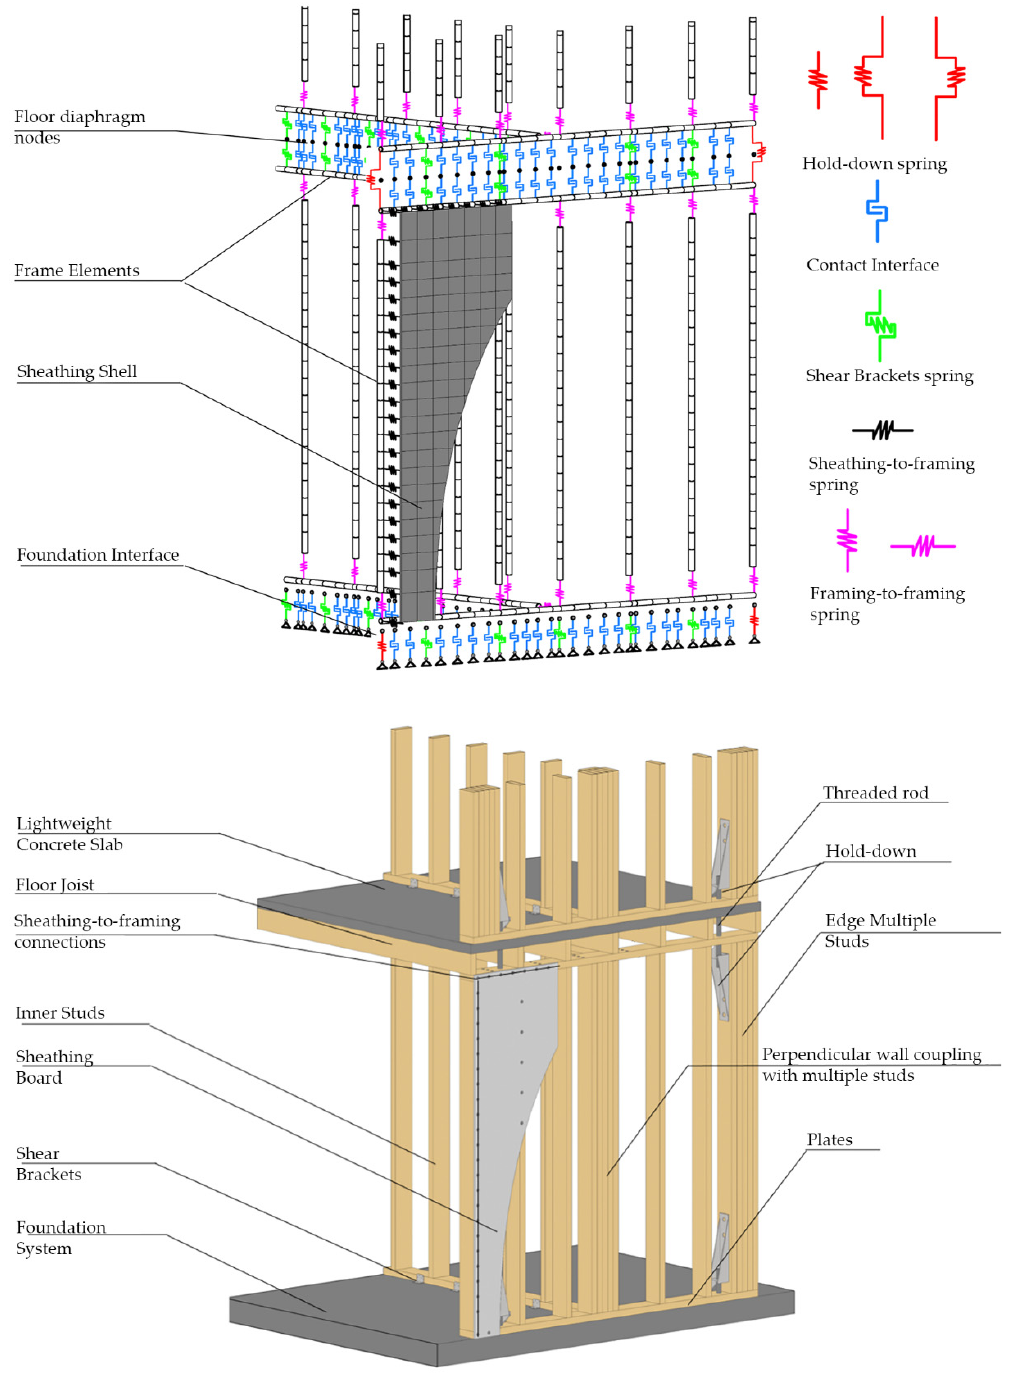
Figure 2. Light-frame timber shear wall components ( below ) and model implementation ( above